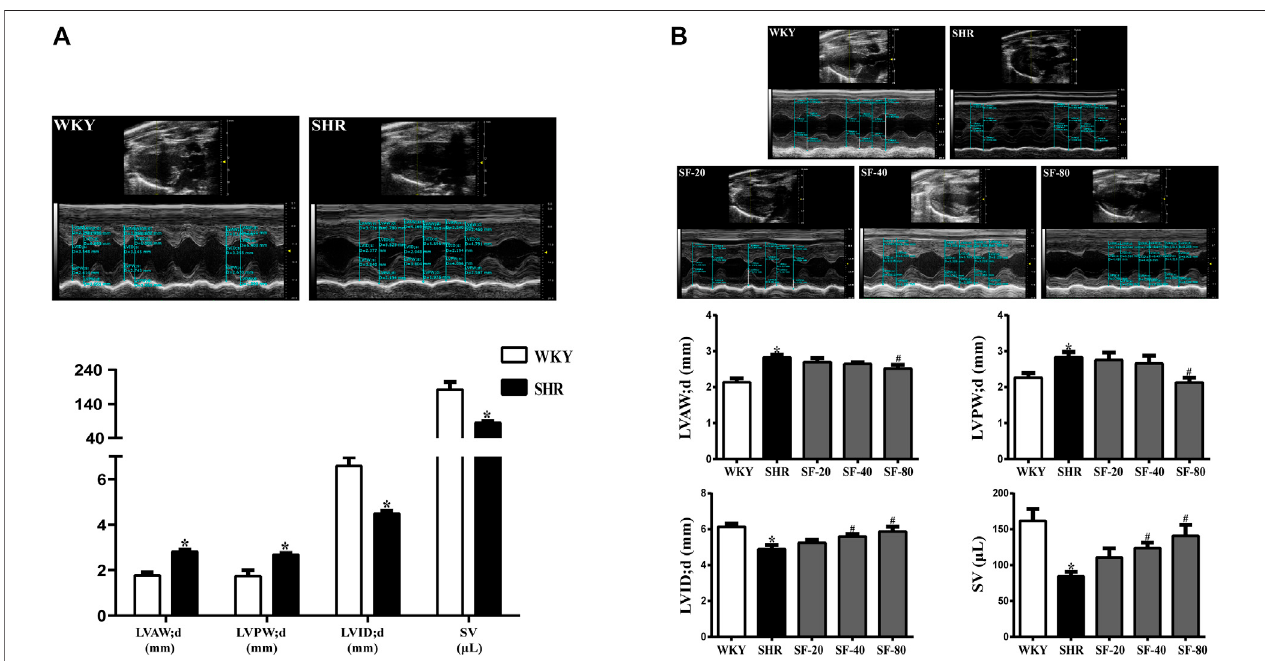
FIGURE 2 | Detection of left ventricular structure and function index in SHRs by small animal ultrasound. (A) The ventricular wall thickness and cardiac function of 14-week-old SHRs were signi fi cantly abnormal compared to WKY rats. ( n (cid:1) 4). (B) SF-40 and SF-80 signi fi cantly improved left ventricular structure and function in 26- week-old SHRs. ( n (cid:1) 6). Data are presented as mean ± SEM. *signi fi cantly different from WKY rats at p < 0.05; # signi fi cantly different from SHRs at p < 0.05.